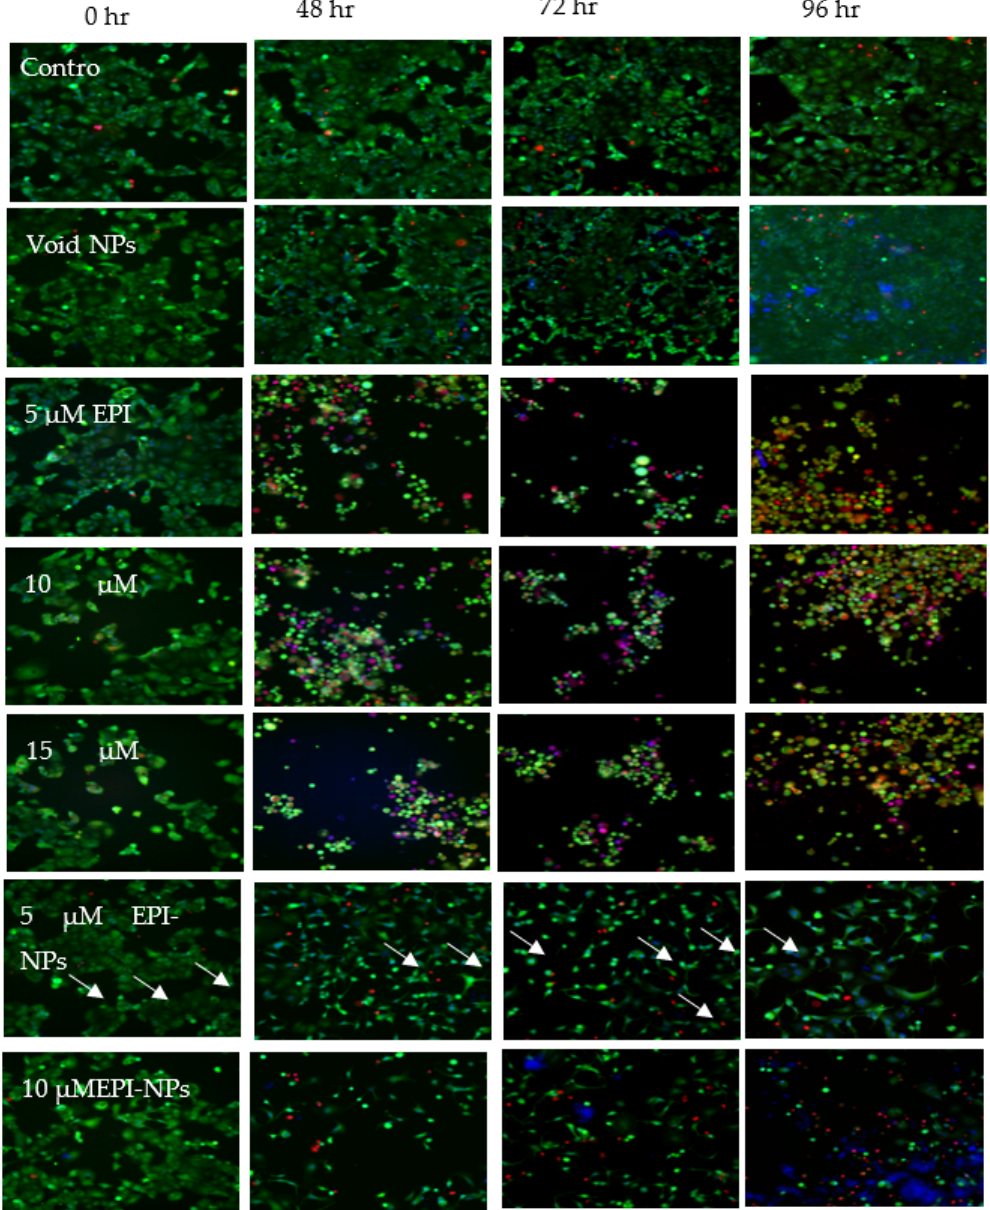
Figure 9. Fluorescence imaging of MCF-7 cells. MCF-7 cells treated with epirubicin (5 µM, 10 µM and 15 µM), epirubicin- loaded nanoparticles (5 µM, 10 µM and 15 µM) and void nanoparticles for 0, 24, 48, 72, 96 h. After treatment, cells were stained with calcein (orange) AM (2 µg/mL), HOECHST33342 (blue) (5 µg/mL), and propidium iodide (red) (2.5 µg/mL) for 20 min. Scale bar of all images is 50 µm. The white arrows points at the condensed nuclei (blue) in apoptotic cells. The red stained cells indicate cell death detected by the propidium iodide staining. The MCF-7 cells show more apoptosis when incubated with 5 µM EPI-NPs and 10 µM EPI-NPs for 96 h, compared with the control and void NPs.